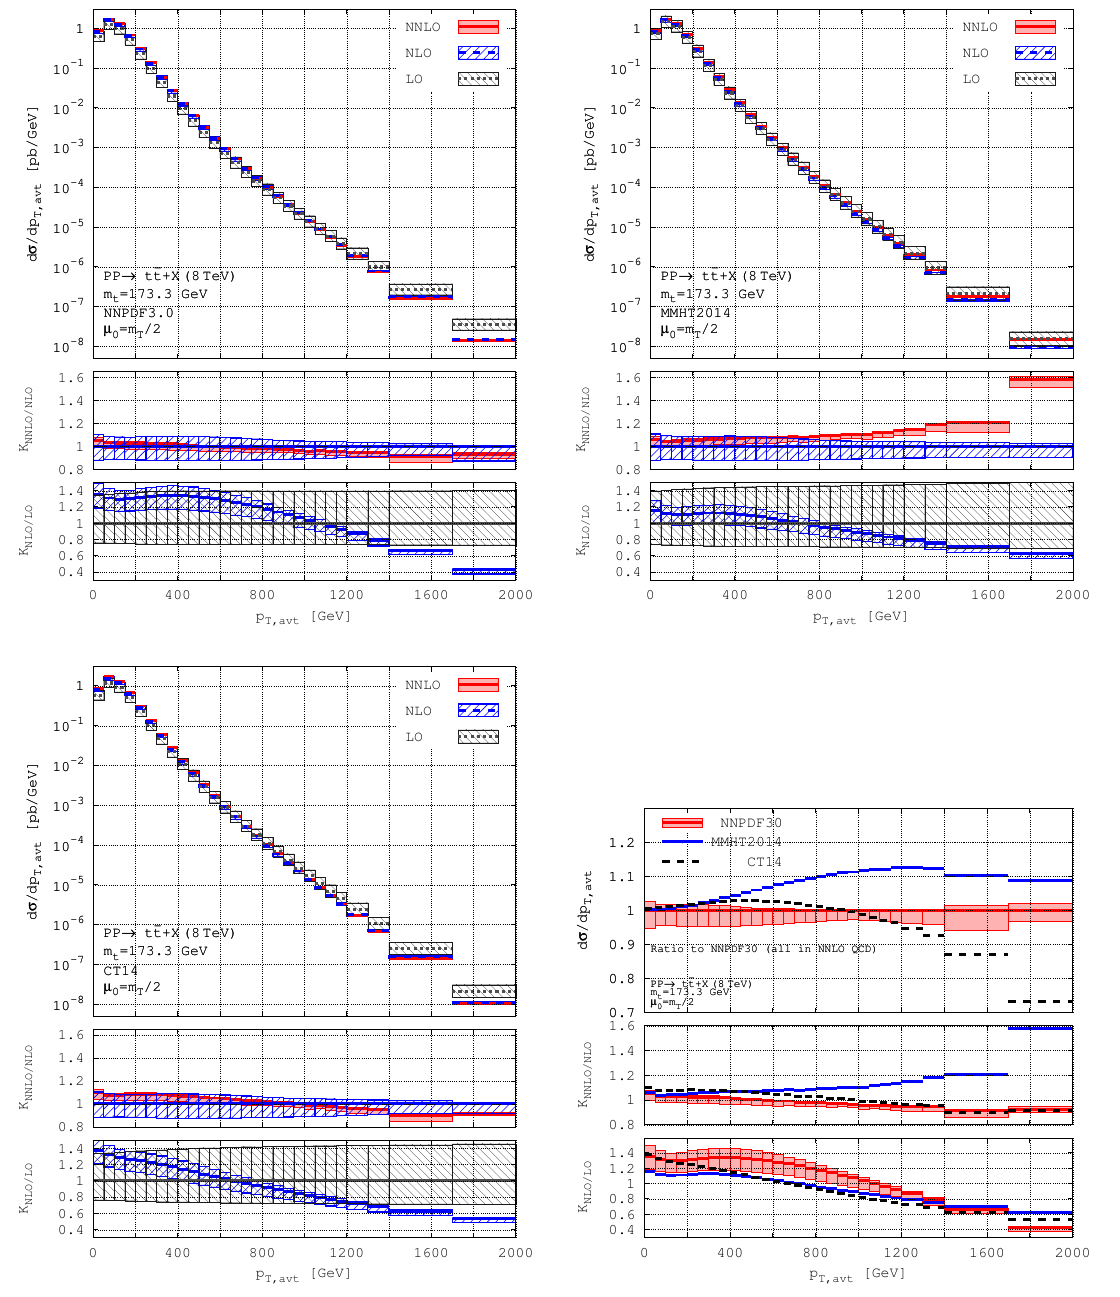
Figure 7 . p distribution for LHC 8 TeV computed with three pdf sets: NNPDF3.0 (top left), T;t= (cid:22) t MMHT2014 (top right) and CT14 (bottom left). The ratios of these distributions with respect to NNPDF3.0 are also shown (bottom right). Error bands are from scale variation only.